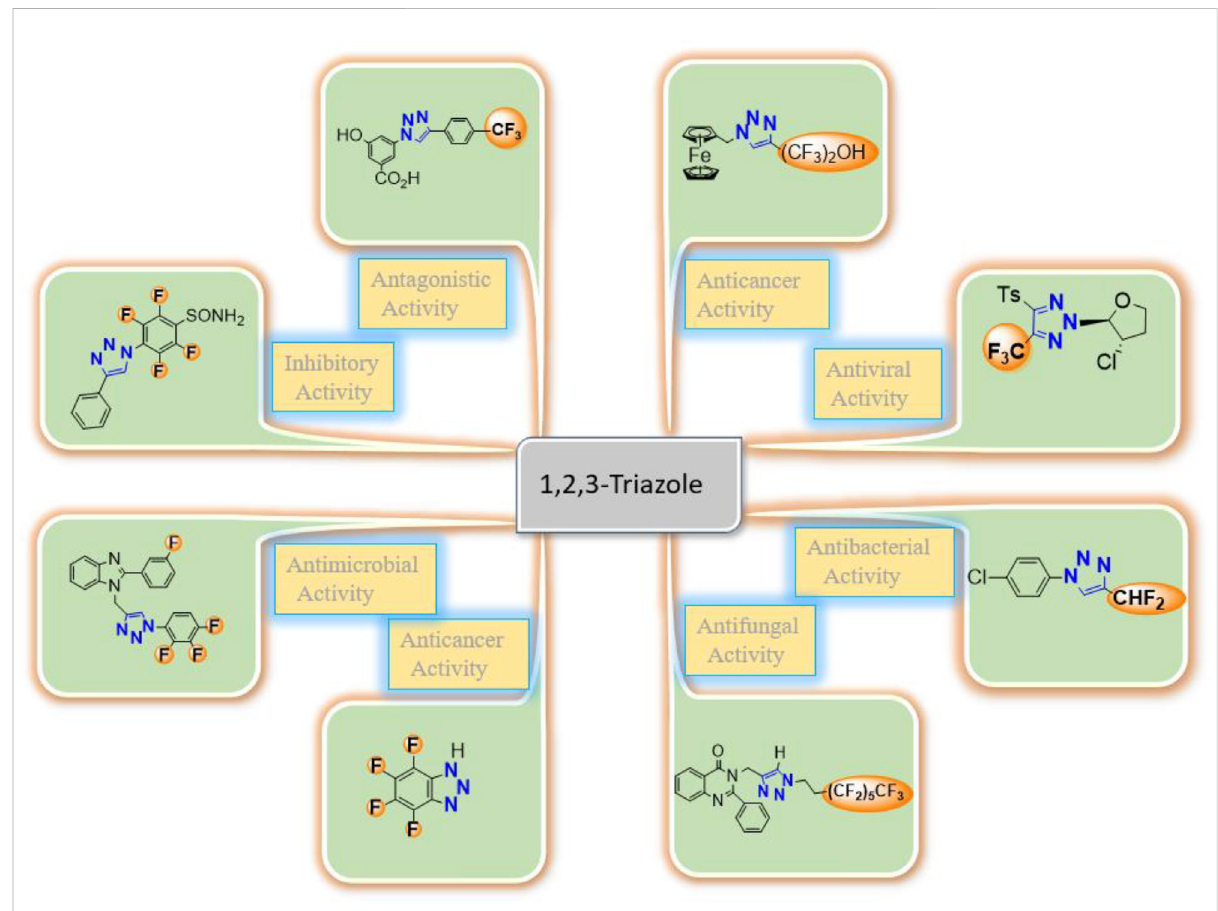
FIGURE 1 Representative examples of biologically important fl uorinated